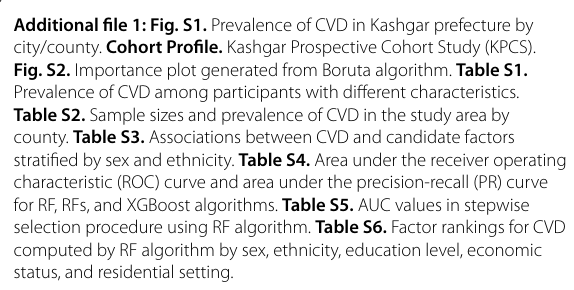
Fig. S2. Importance plot generated from Boruta algorithm. Table S1. Prevalence of CVD among participants with different characteristics. Table S2. Sample sizes and prevalence of CVD in the study area by county. Table S3. Associations between CVD and candidate factors stratified by sex and ethnicity. Table S4. Area under the receiver operating characteristic (ROC) curve and area under the precision‑recall (PR) curve for RF, RFs, and XGBoost algorithms. Table S5. AUC values in stepwise selection procedure using RF algorithm. Table S6. Factor rankings for CVD computed by RF algorithm by sex, ethnicity, education level, economic status, and residential